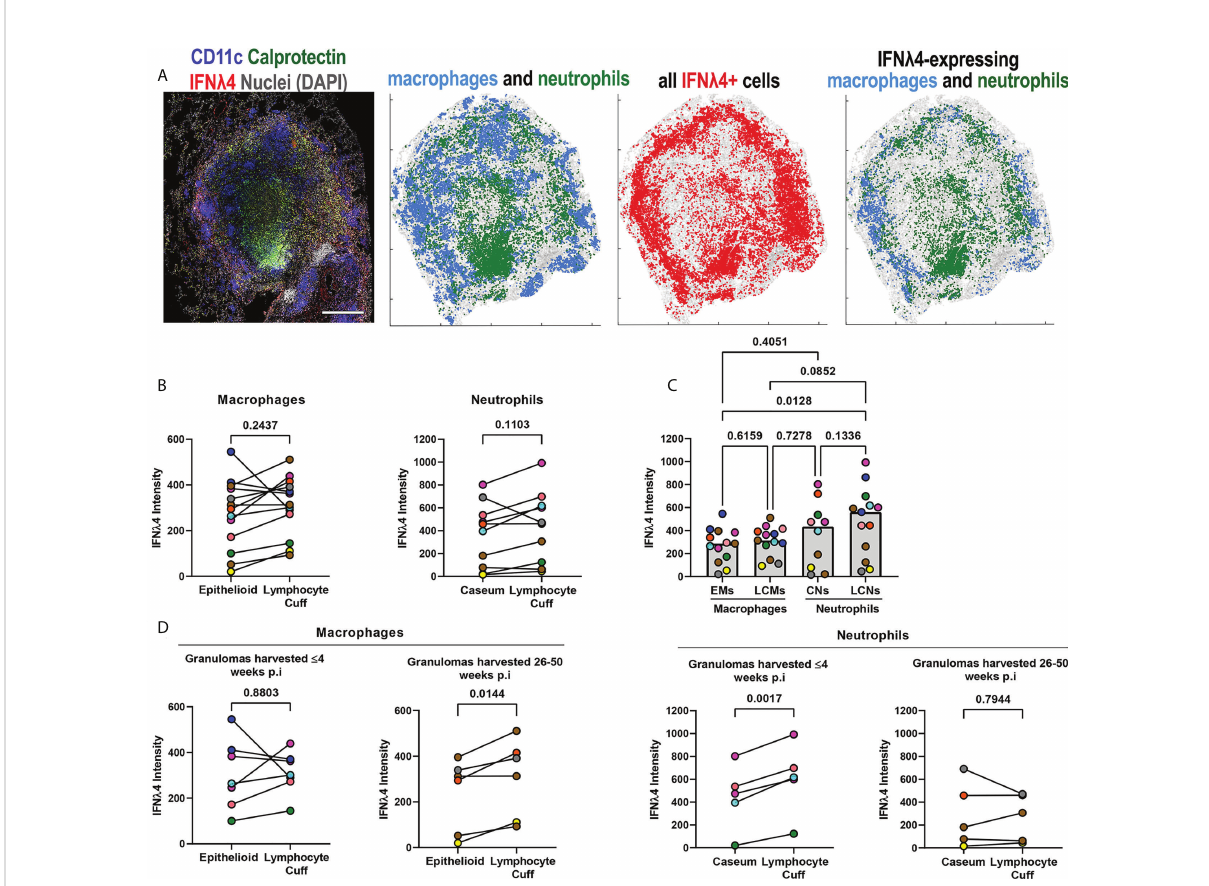
FIGURE 5 IFN l 4 expression varies by granuloma microenvironment. (A) A representative granuloma stained to identify IFN l 4 (red) expressed by CD11c+ macrophages (blue) and calprotectin+ neutrophils (green) (right). Scale bar represents 500 m m. Spatial distribution of macrophages (blue) and neutrophils (green) in the granuloma, distribution of IFN l 4 (red), and distribution of IFN l 4+ macrophages (blue) and neutrophils (green). (B) Comparison of IFN l 4 expression, as measured by median fl uorescence intensity per cell subset per granuloma, for epithelioid and lymphocyte cuff macrophages (n=13) (left), and caseum and lymphocyte cuff neutrophils (n=10) (right). Statistical comparisons by paired t test. (C) Comparison of median IFN l 4 intensity in epithelioid macrophages, lymphocyte cuff macrophages, caseum neutrophils, and lymphocyte cuff neutrophils (n=13 granulomas). A mixed effect test used to account for repeated measures and pairwise groups compared using Tukey ’ s multiple comparisons test (Tukey adjusted p-values reported). (D) Comparison of IFN l 4 expression, as measured by fl uorescence intensity, between epithelioid and lymphocyte cuff macrophages (left) in granulomas harvested within 4 weeks post-infection (n=7) or 26-50 weeks post- infection (n=6). A similar comparison of IFN l 4 expression by caseum and lymphocyte cuff neutrophils (right) from granulomas harvested by 4 weeks post-infection (n=5) and between 26-50 weeks post-infection (n=5). Statistical comparisons by paired t